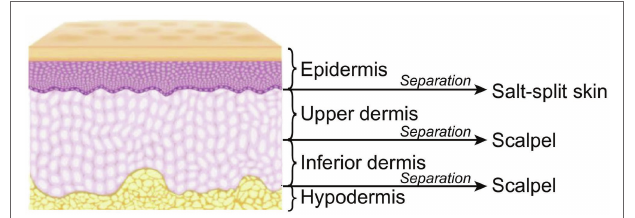
FIGURE 1 | Schematic representation of the procedures used in the separation of skin